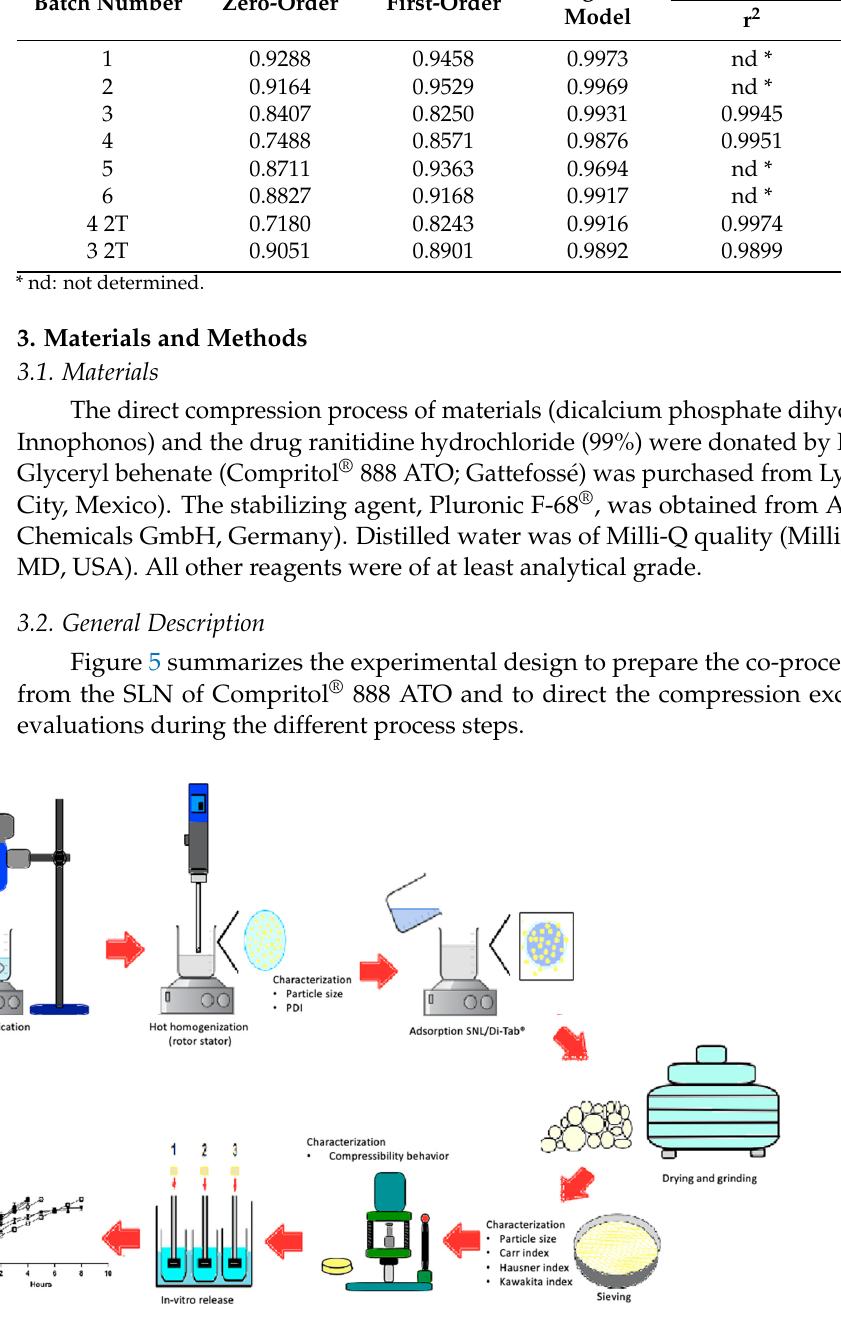
Figure 5. Experimental procedure to obtain a co-processed